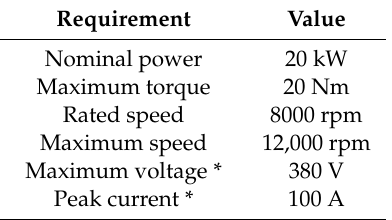
Table 1. Requirements for each internal permanent magnet synchronous machine (IPMSM).